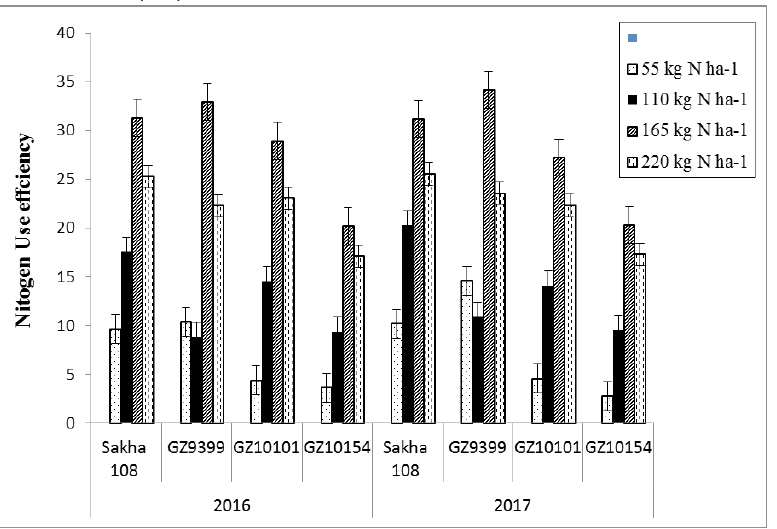
Fig. 5. Effects of interaction between rice genotypes and N levels on nitrogen use efficiency during the 2016 and 2017 growing seasons. Vertical bars represent ±standard error